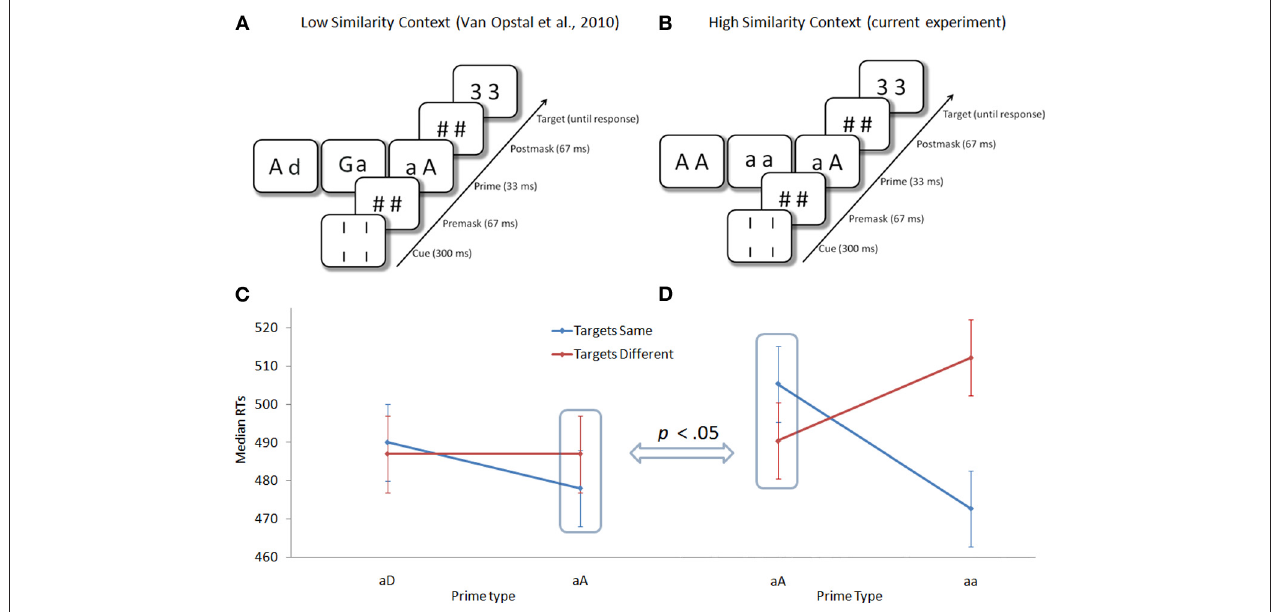
FIGURE 2 | (A,B) Task-set-up. (C,D) Response times for the low-similarity and high-similarity context for the different prime types and prime-target congruency. Adapted with permission from van Opstal et al.